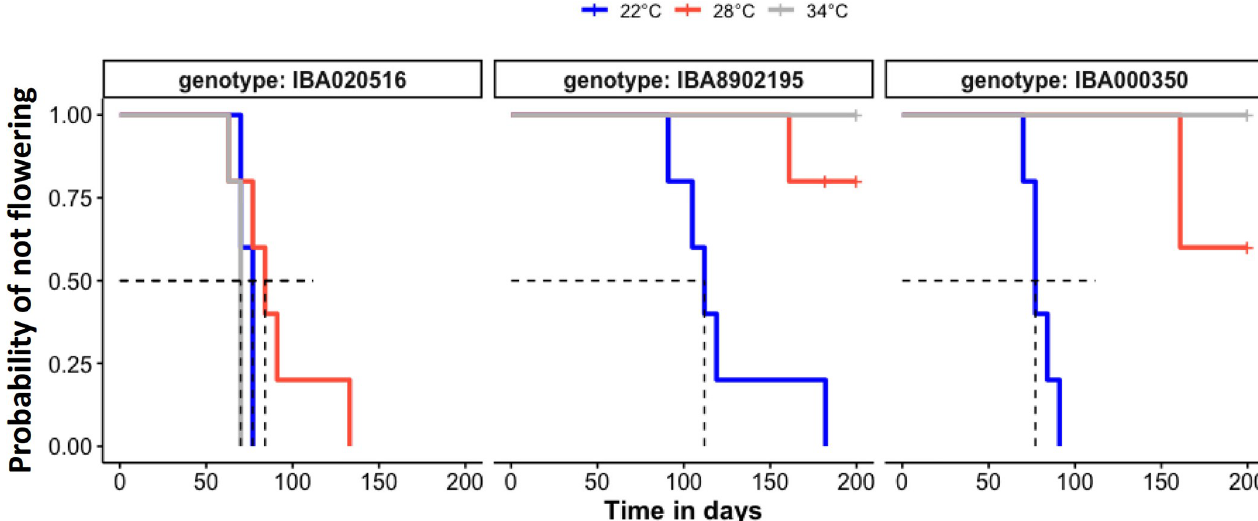
Fig 6. Flowering time probabilities for three genotypes in controlled-environment growth chambers at three temperatures treatments (day/night): 22/ 18˚C (blue), 28/22˚C (red), and 34/30˚C (gray). Kaplan-Meier curves show the time course of probability of not flowering in each location. Horizontal and vertical dashed lines indicate, respectively, 50% probability of flowering and corresponding days after planting